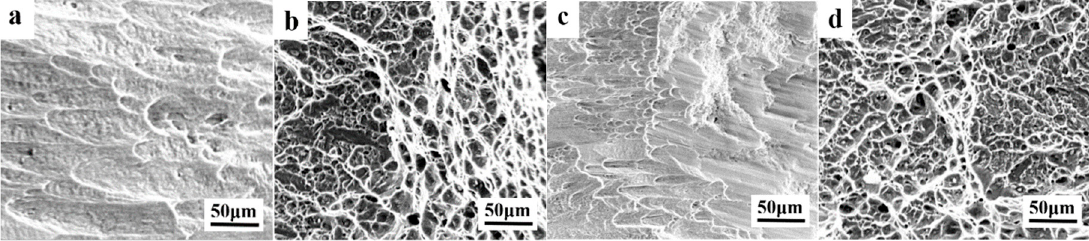
Figure 6. SEM images of the compressive fractured surface of the ( a ) edge and ( b ) center of the Fe 65.4 Mn 14.3 Si 9.4 Cr 10 C 0.9 alloy, and the ( c ) edge and ( d ) center of the Fe 64.4 CeMn 14.3 Si 9.4 Cr 10 C 0.9 alloy.